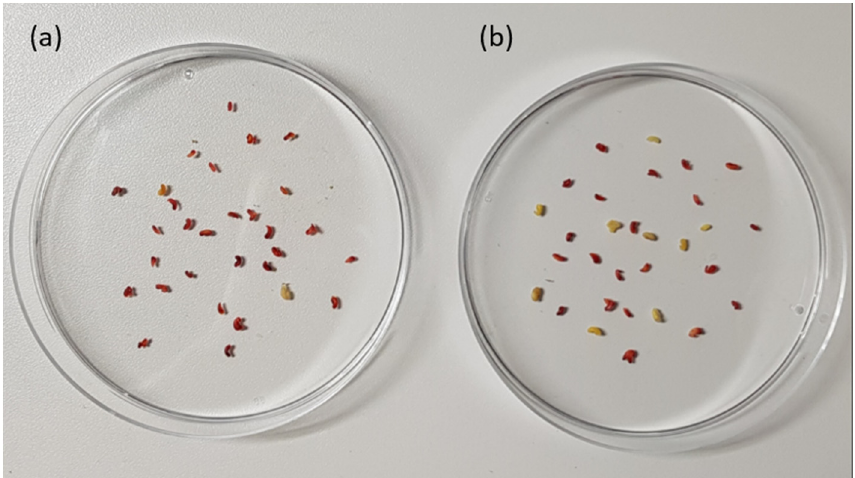
Figure 2. Number of viable Medicago sativa seeds, as shown by the red/pink colour of seeds following